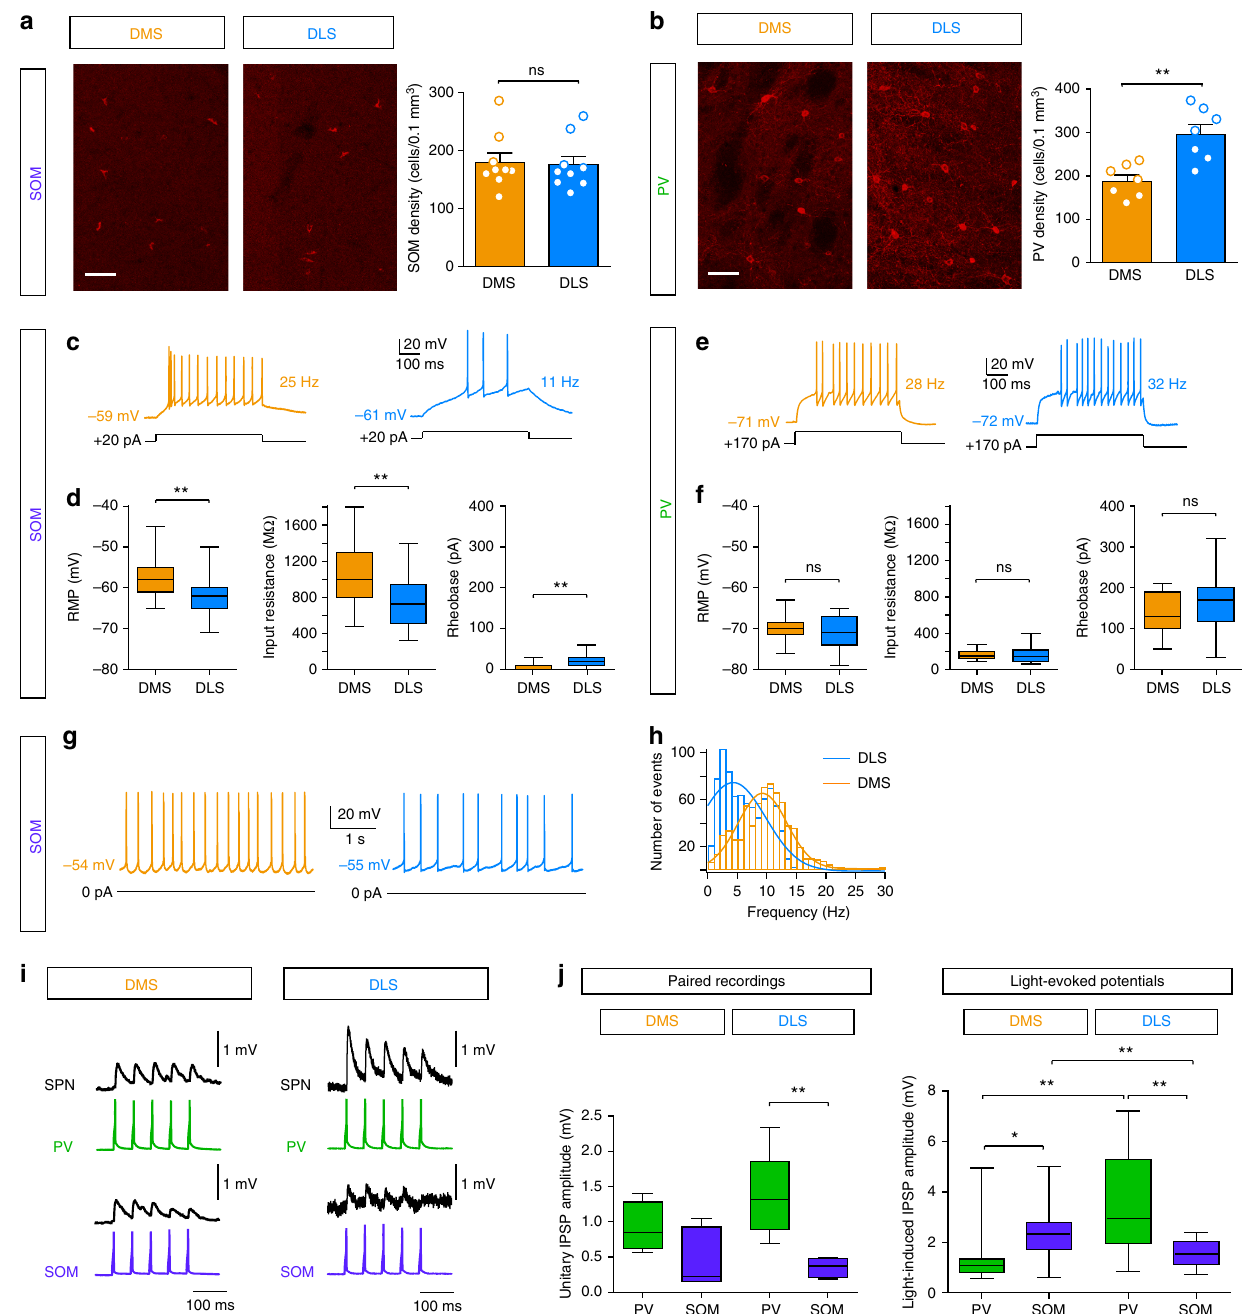
Fig. 5 Heterogeneous distribution, electrical properties and connectivity of SOM and PV cells in DMS and DLS. a , b Confocal microscopy images showing a representative overview of SOM ( a ) and PV ( b ) interneuron expression in DMS and DLS (scale bars: 50 µ m), identi fi ed following immunostainings. On the right panels, quanti fi cation of SOM ( a ) and PV ( b ) interneurons in DMS and DLS is represented by the cell density (number of cells per 0.1mm 3 ) of SOM and PV interneurons in each territory ( n = 9 mice for SOM interneurons and n = 7 mice for PV interneurons). c Representative responses of SOM cells to identical current steps ( + 20pA) in DLS and DMS. d Membrane and electrical properties of SOM cells in DMS (orange, n = 20) and DLS (blue, n = 27) (mean±SEM). e Representative responses of PV cells to identical current steps ( + 170pA) in DLS and DMS. f Membrane and electrical properties of PV cells in DMS (orange, n = 17) and DLS (blue, n = 30). There is no signi fi cant difference in rheobase ( p = 0.2761), RMP ( p = 0.6030) and input resistance ( p = 0.3260) of PV cells in DMS or in DLS. g Representative spontaneous activity of SOM cells in DMS and DLS. h Distribution and Gaussian fi ts of the discharge frequency in DLS (100 action potentials per cell, n = 8) and DMS ( n = 6): the frequency is signi fi cantly higher in DMS ( p <0.0001). i Representative connections between of PV-SPN and SOM-SPN connections in DMS and DLS in response to 20Hz single AP trains evoked in PV and SOM cells with current injections. j Amplitude of unitary IPSPs in a SPN (single AP with paired patch-clamp recordings) in DMS and DLS. For PV-SPN connections the unitary IPSP was median (interquartile range (IQR)): 0.9 (0.6)mV ( n = 5) in DMS and 1.3 (0.7)mV in DLS ( n = 6) and for SOM-SPN connections 0.3 (0.8)mV ( n = 6) in DMS and 0.4 (0.2)mV in DLS ( n = 4). They were not statistically different in DMS ( p = 0.0648) but much stronger from PV in DLS ( p = 0.0094). Concerning light-induced IPSP amplitudes, SOM cell opto- activation induced signi fi cantly stronger IPSPs in DMS ( p = 0.0158) and PV cells in DLS ( p = 0.0019) (SOM-DMS: 2.3 (1.1)mV, n = 19, PV-DMS: 1.1 (0.5)mV, n = 16, SOM-DLS: 1.5 (1.1)mV, n = 14, and PV-DLS: 2.9 (3.2)mV, n = 15). * p <0.05, ** p <0.01, ns not signi fi